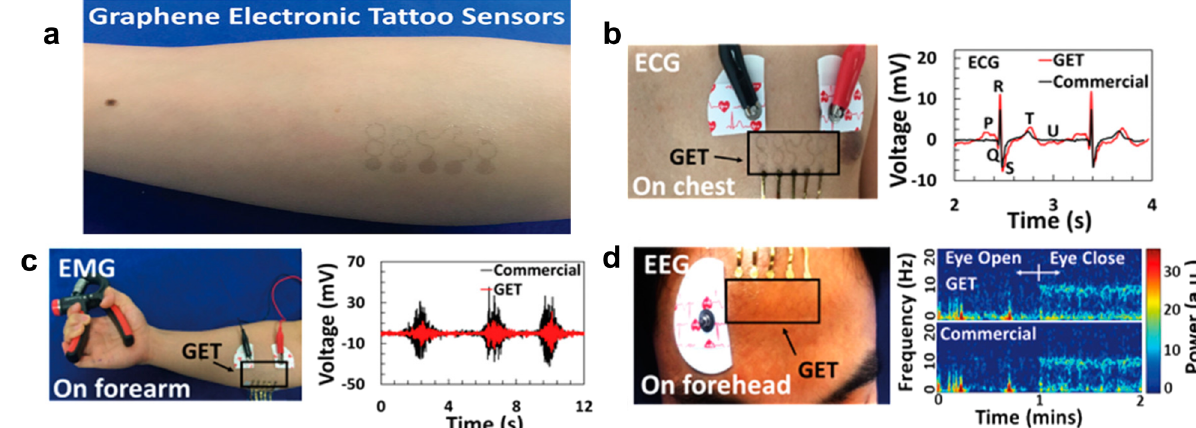
Fig. 3 E-skin-based HWDs. a A graphene electronic tattoo (GET) embossed on the forearm. b A comparison of ECG acquired using GET and commercial ECG monitor from chest. c EMG signals using GET from forearm. d EEG values using GET from forehead and frequency response of EEG during open and closed eyes condition highlighting the presence of alpha waves during eyes closed. Reproduced with permission from Ameri et al. 33 Copyright © ACS Nano,